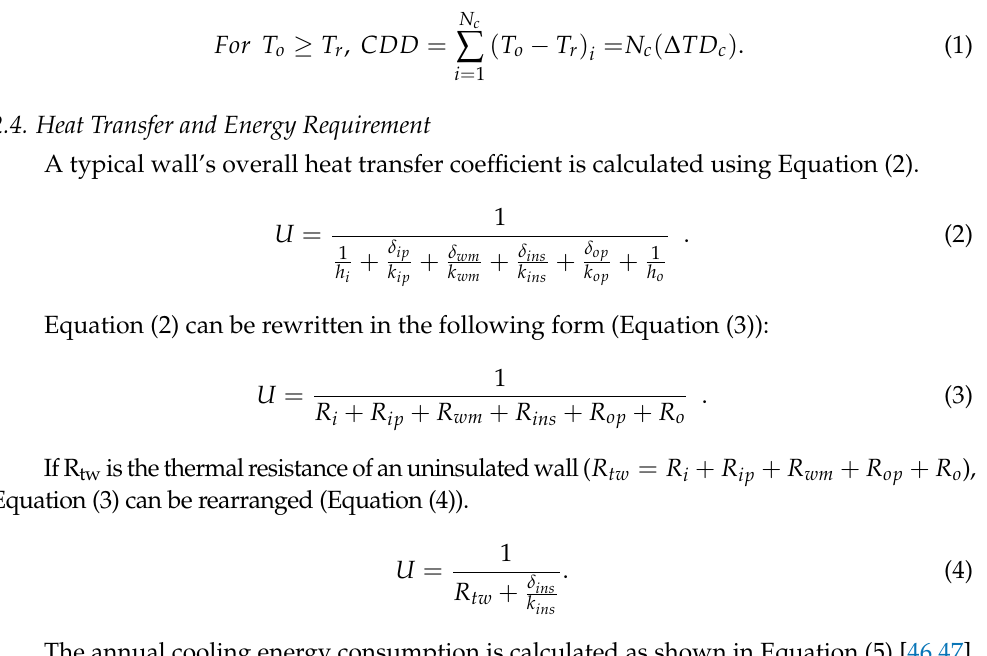
Specific Heat (J/kgK)